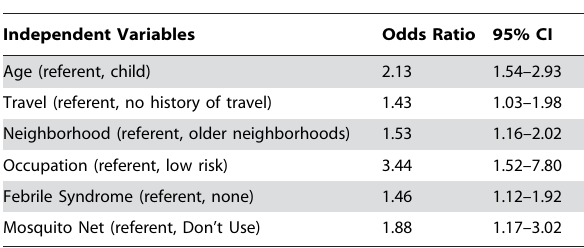
Table 6. Adjusted odds ratios of potential risk factors associated with VEEV antibody status, based on a stepwise multivariate logistic regression model.